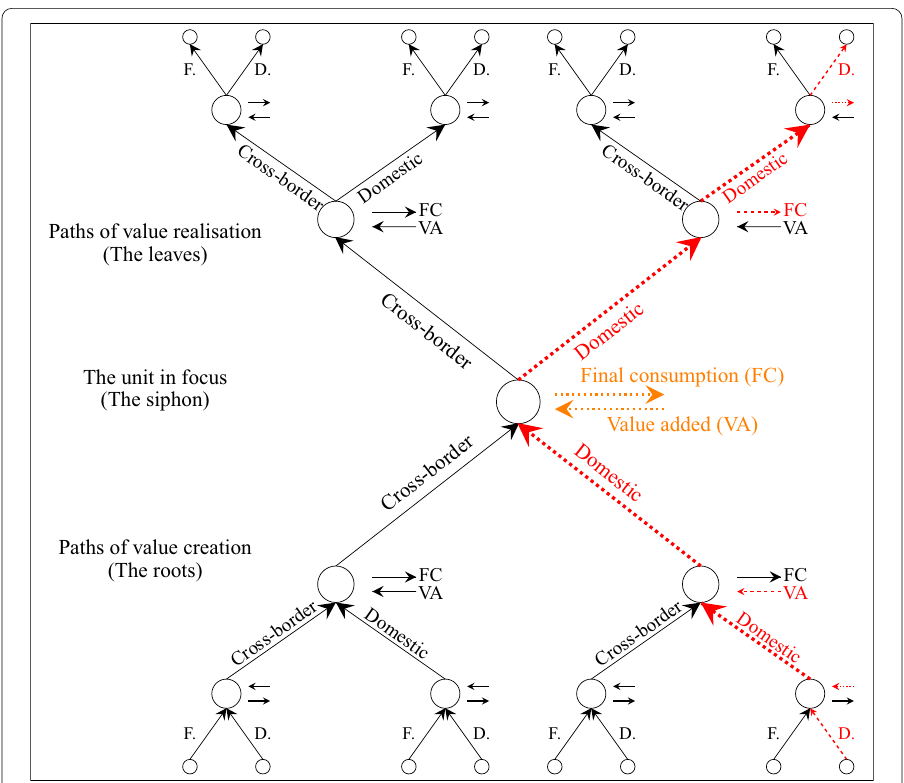
Fig. 1 Value chain tree. Source: own conceptualisation and design. Arrows represent production-sharing transactions—buying and selling of intermediate products for production. Orange colour denotes production that does not involve any production sharing, while any combination of red or orange paths denotes domestic production fragmentation. Any value chain path which includes a cross-country production-sharing transaction (a black arrow) is part of a global value chain from the perspective of the particular unit in focus. The paths of value creating and value realisation in a general case continue to branch ad infinitum (three levels are chosen only for demonstration